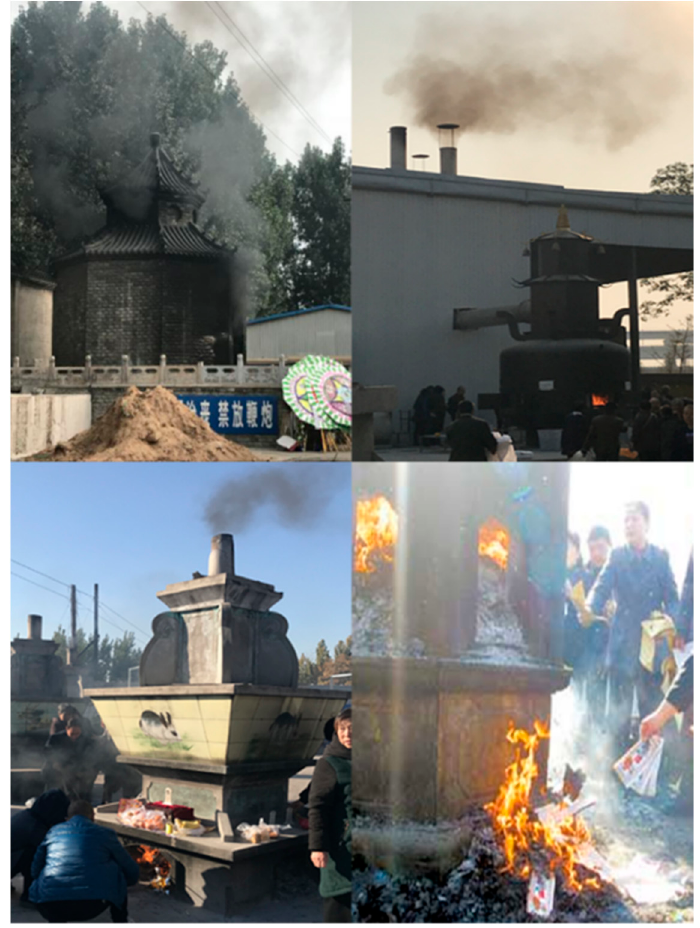
Figure 1. Sites of the incinerator for sacrificial offerings.